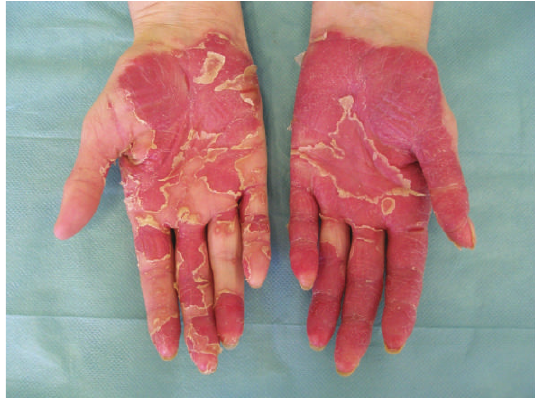
Figure 19: Psoriasis.